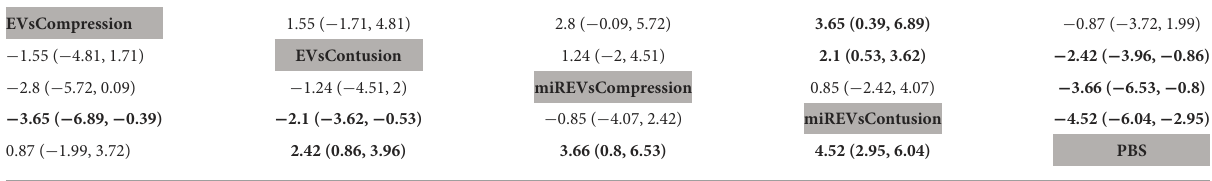
TABLE 6 League table of BBB scores in different models at 14 days after